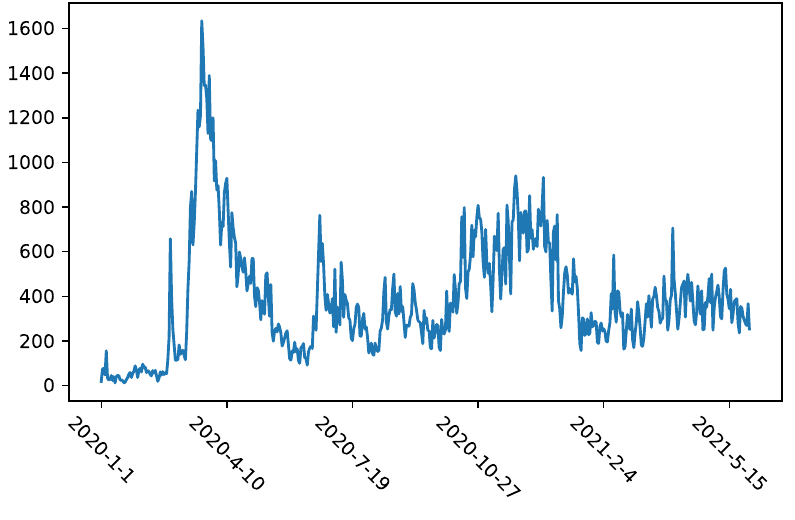
Figure 1. Frequency of COVID-19-related tweets during the three pandemic